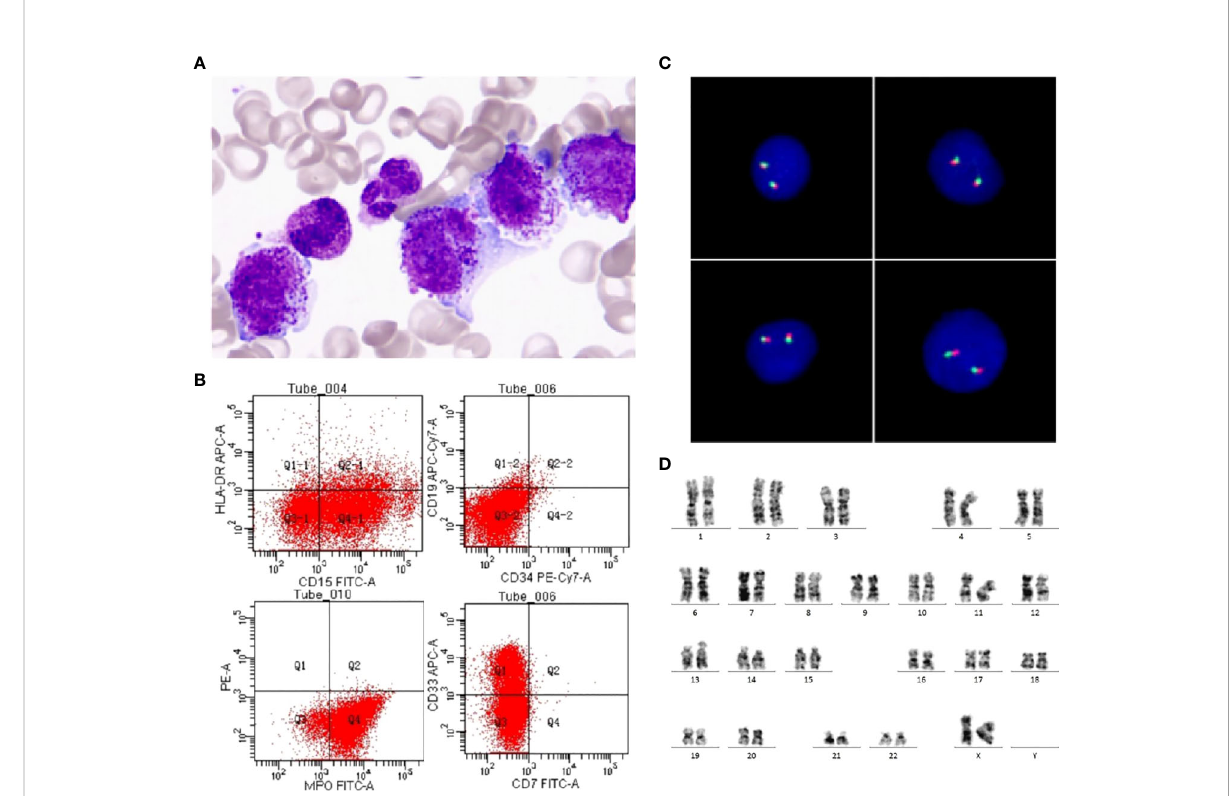
FIGURE 1 Morphology, immunophenotyping, FISH and karyotyping. (A) An increased number of promyelocytes, which contained azurophilic granules or Auer bodies (Wright-Giemsa staining of bone marrow, ×1000). (B) Leukemia cells expressed MPO, CD13, CD15, CD33, but do not express CD34, HLA-DR. (C) No PML-RARA fusion signals were detected by FISH using PML-RARA Dual Color, Dual Fusion Translocation Probe. (D) Chromosome G band analysis revealing karyotype 46,XX